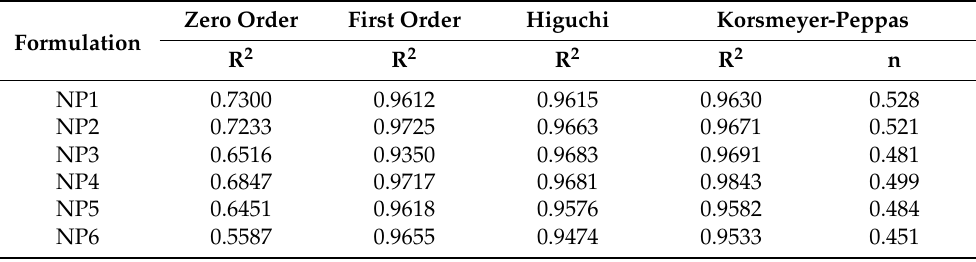
Table 6. Kinetic model of drug release from NPs.